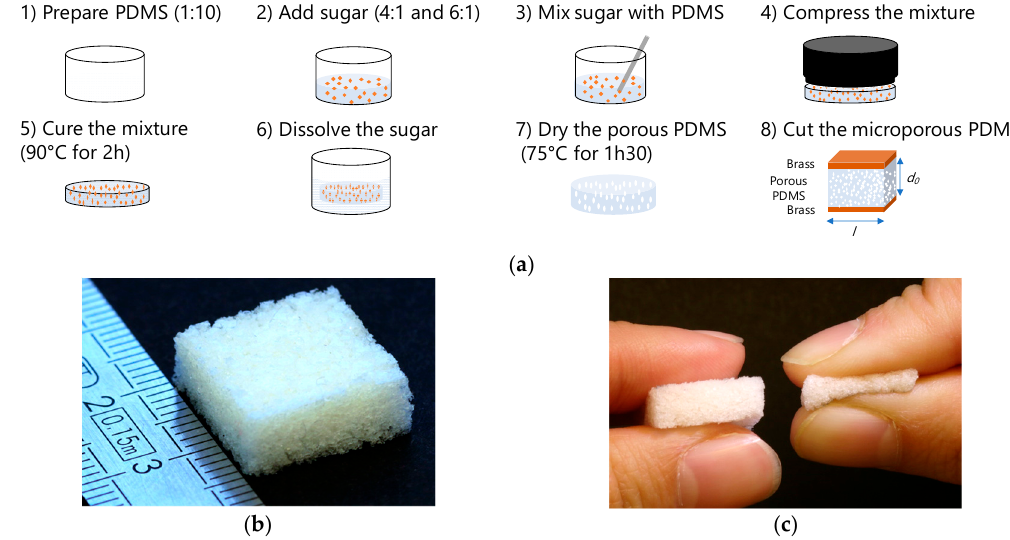
Figure 2. ( a ) Fabrication process of the microporous PDMS foams; ( b ) example of 4:1 small pore PDMS foam sample; ( c ) compressibility of the of 4:1 small pore PDMS foam sample.